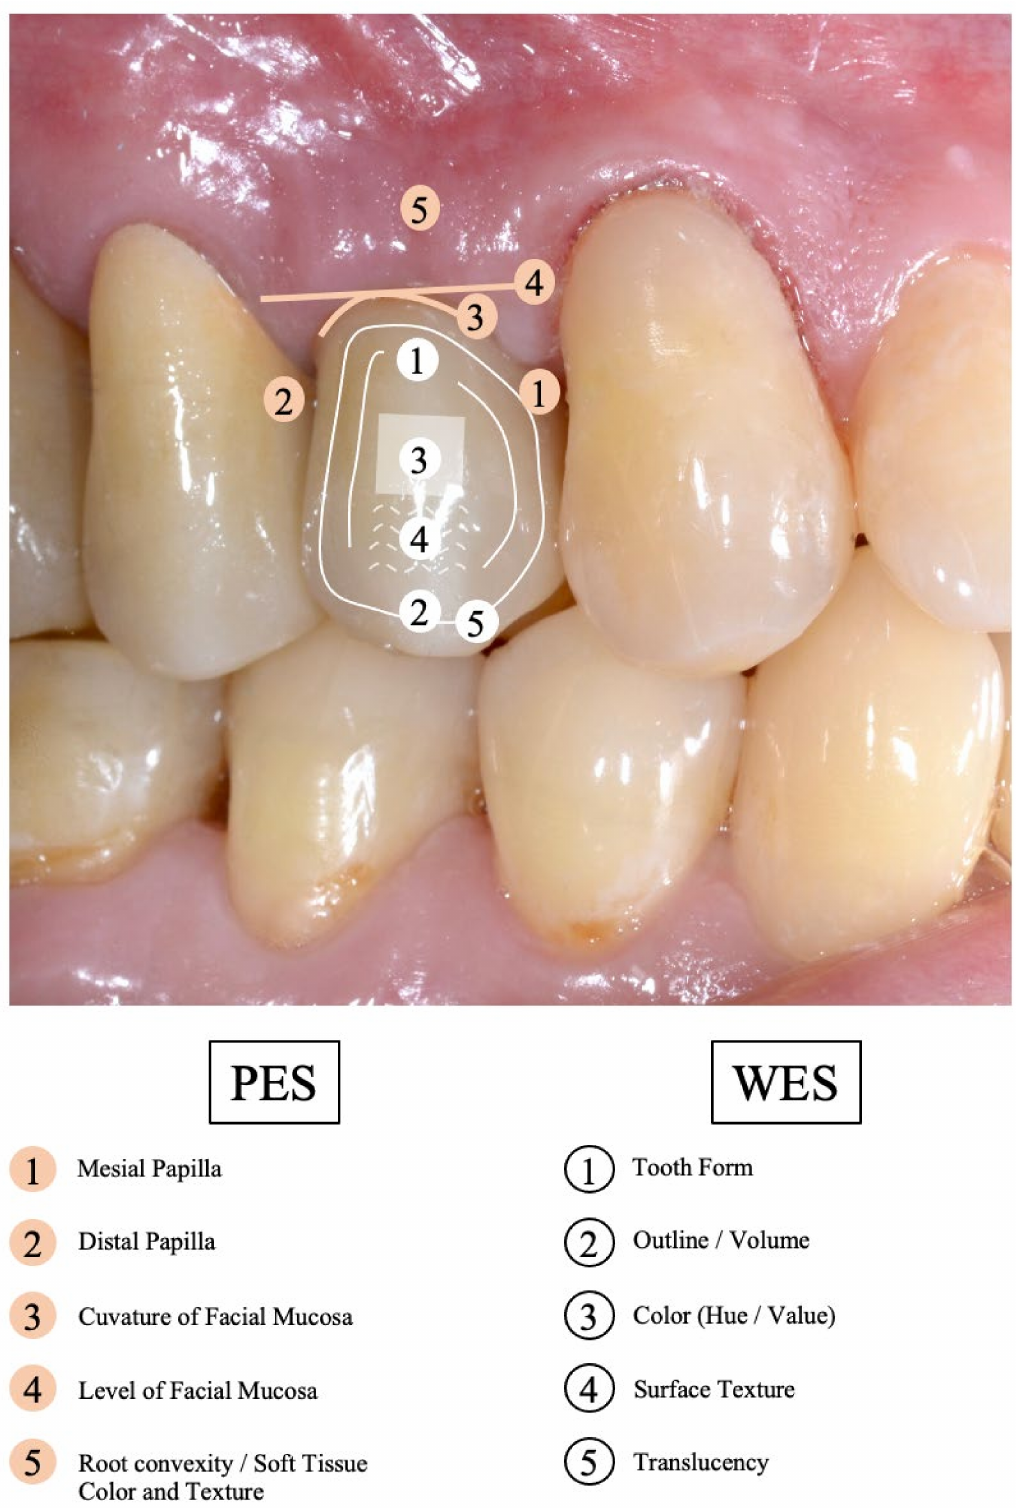
Figure 4. Clinical photograph of an implant of the platform switching group with detailed description of parameters evaluated for the Pink and White Esthetic